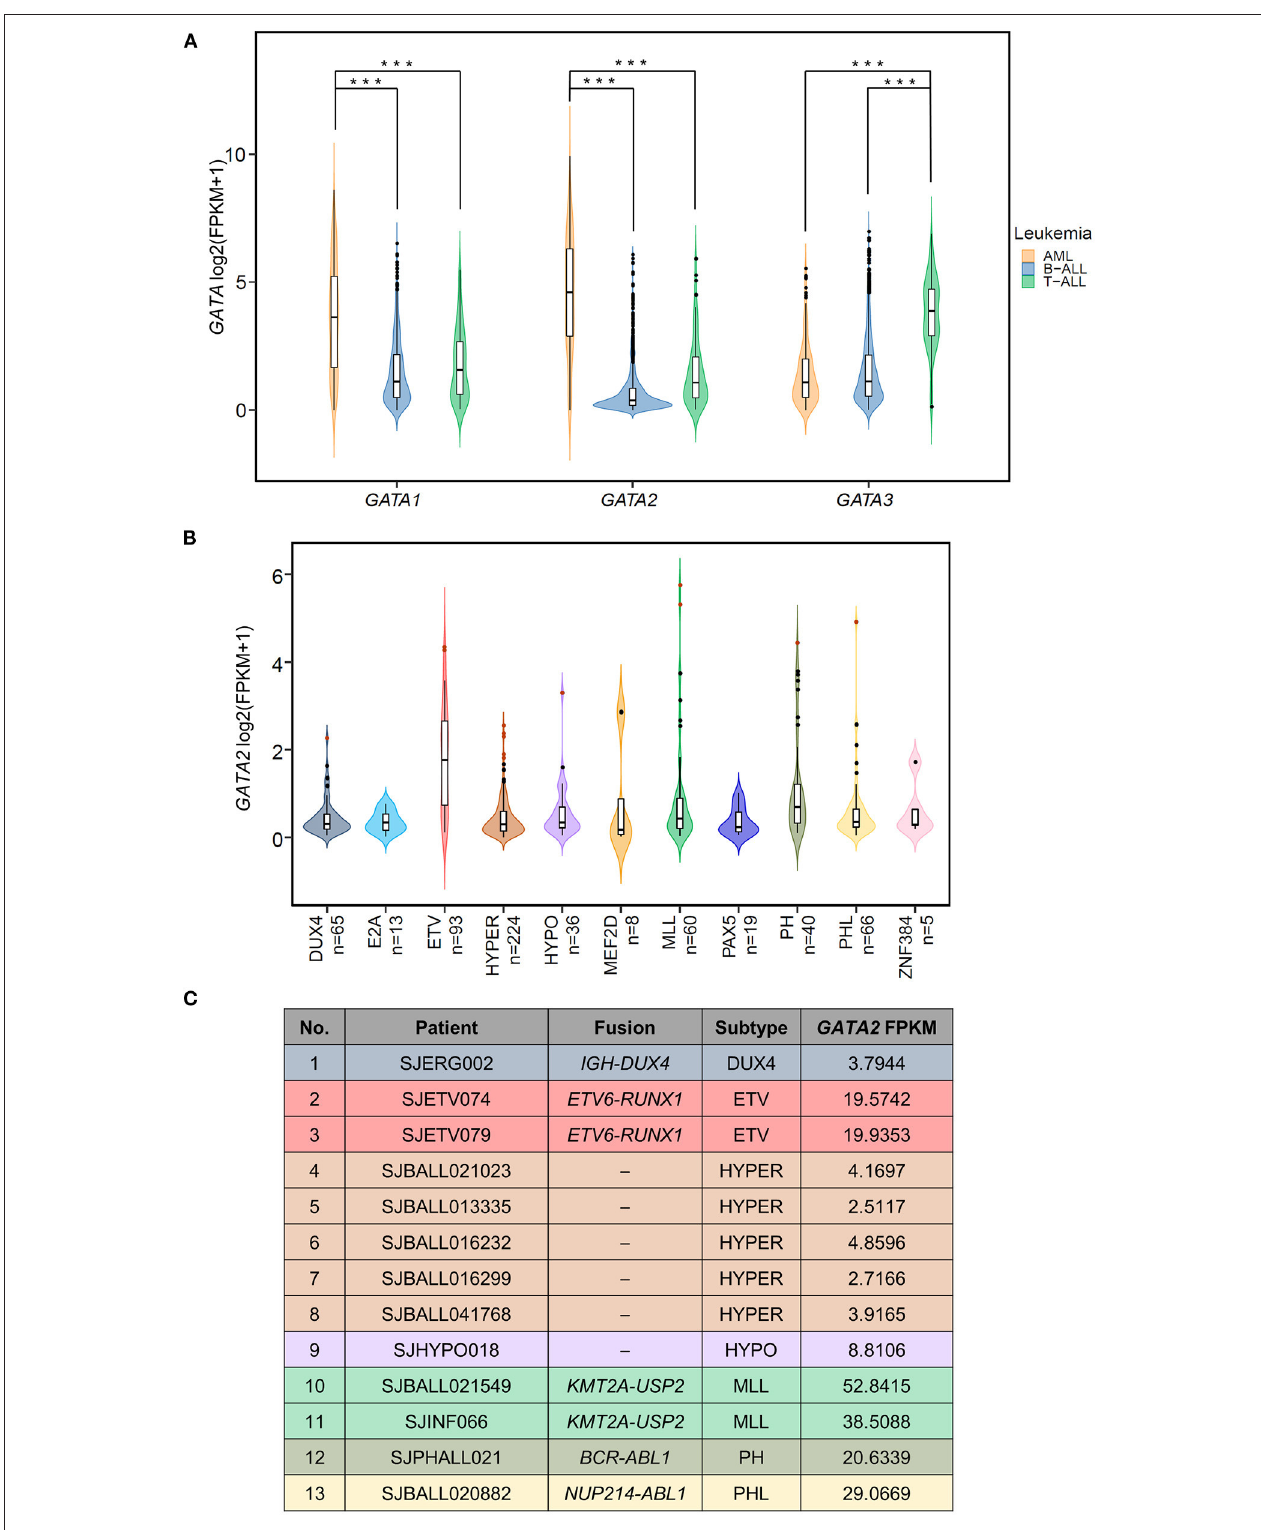
FIGURE 1 | Aberrant transcription of GATA2 in leukemia. (A) Violin plots showing the expression of three hematopoietic GATA transcription factors in pediatric leukemia patients; expression data are from St. Jude Cloud (AML n = 297, T-ALL n = 99, B-ALL n = 1,248). *** p < 0.001. (B) The GATA2 expression levels in 629 B-ALL patients with definitive subtype information were plotted. Thirteen GATA2 -outlier patients were shown in red dots. (C) Information from 13 GATA2 -outlier cases (i.e., sample ID, subtype, major type of fusion, and GATA2 FPKM) is listed.